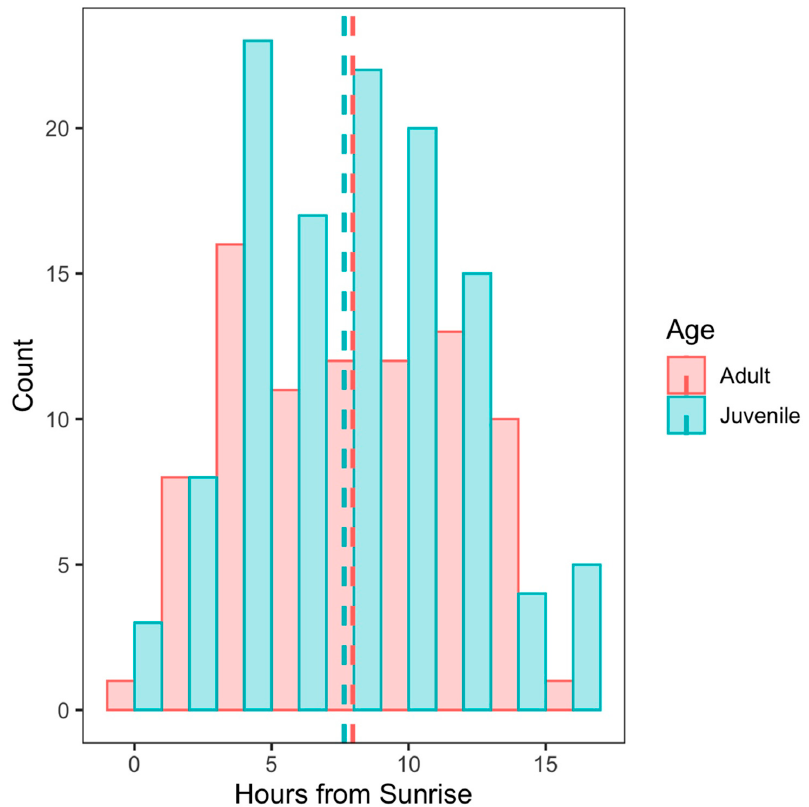
Figure 5. Age and Hours from Sunrise. Histograms showing when rattlesnakes were observed in terms of hours from sunrise. Calculated average values of hours from sunrise for adults and juveniles are indicated by the dashed vertical lines.